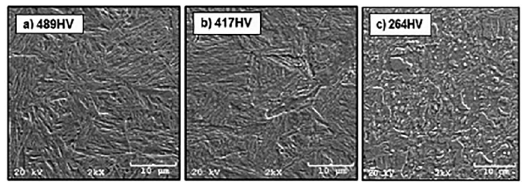
Figure 11: SEM observations showing microstructures of 0.70mm gap test specimen in different regions: (a) cooled region, (b) region near cooler, (c) region far from cooler.